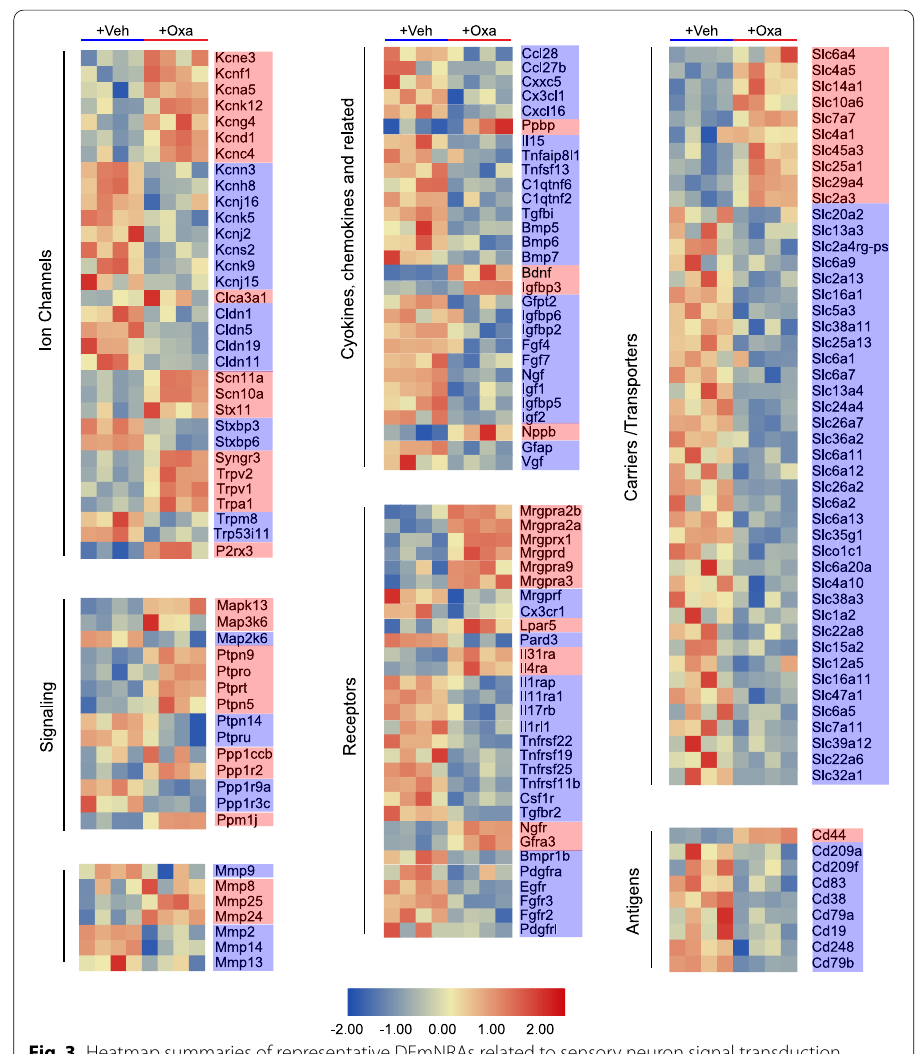
Fig. 3 Heatmap summaries of representative DEmNRAs related to sensory neuron signal transduction, pain, itch, and inflammation. Red genes indicate upregulated DEmRNAs, whereas blue genes indicate downregulated